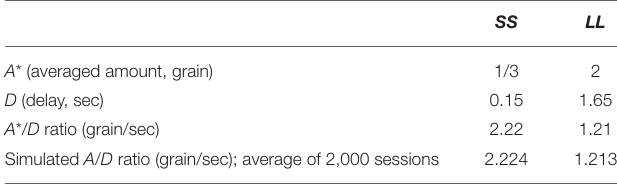
TABLE 1 | Amount, delay, and A / D ratio ( simulation 1 ).